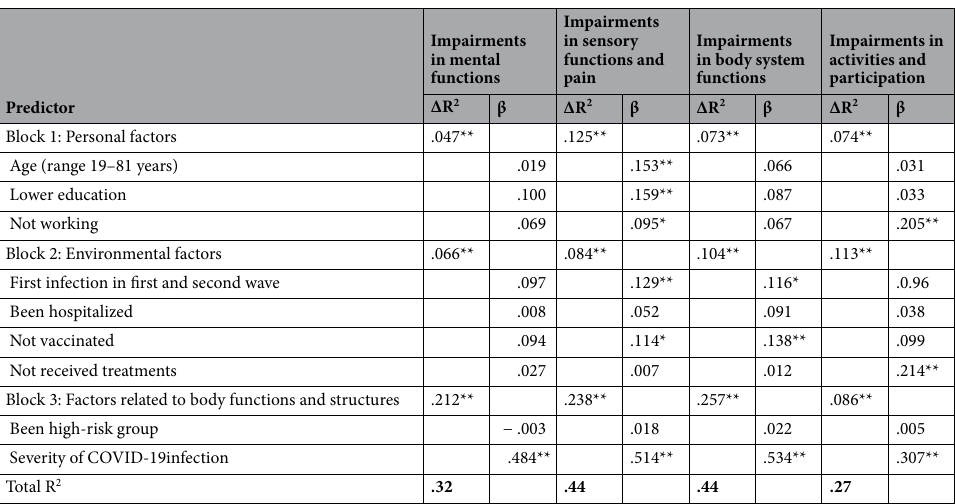
Table 4. Hierarchical multiple regression analyses of personal factors, environmental factors, and factors related to body functions and structures and post-COVID impairments. ΔR 2 = R square change; β = Standardized regression coefficient. * p < .05, ** p <